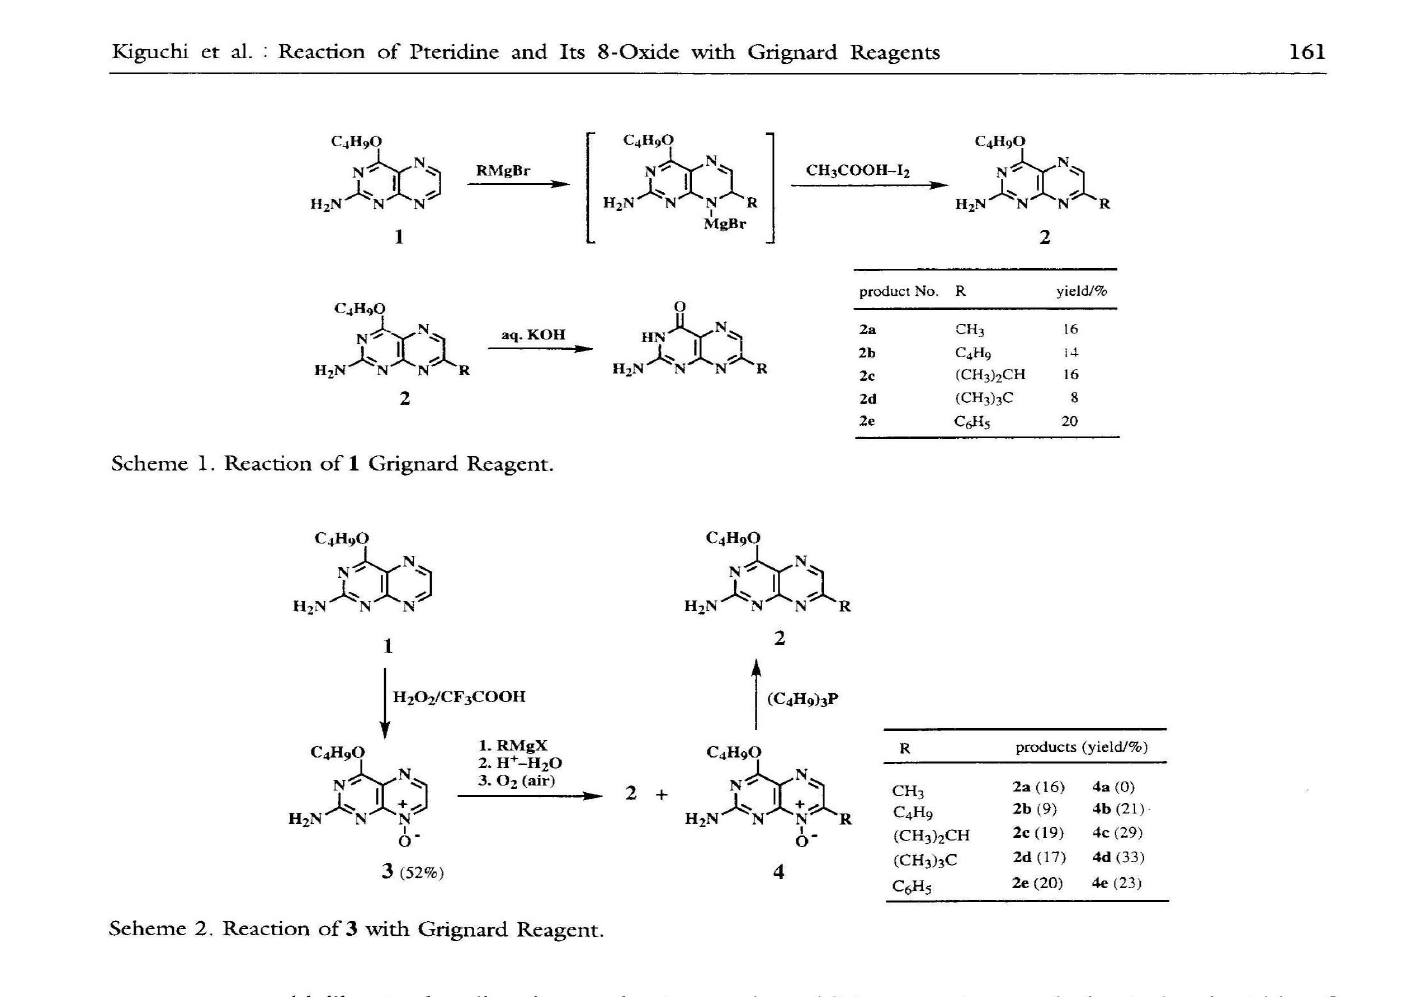
Scheme 1. Reaction of 1 Grignard